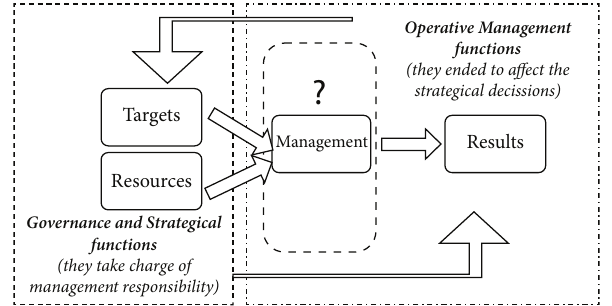
Figure 5. Distortions of system performance and network